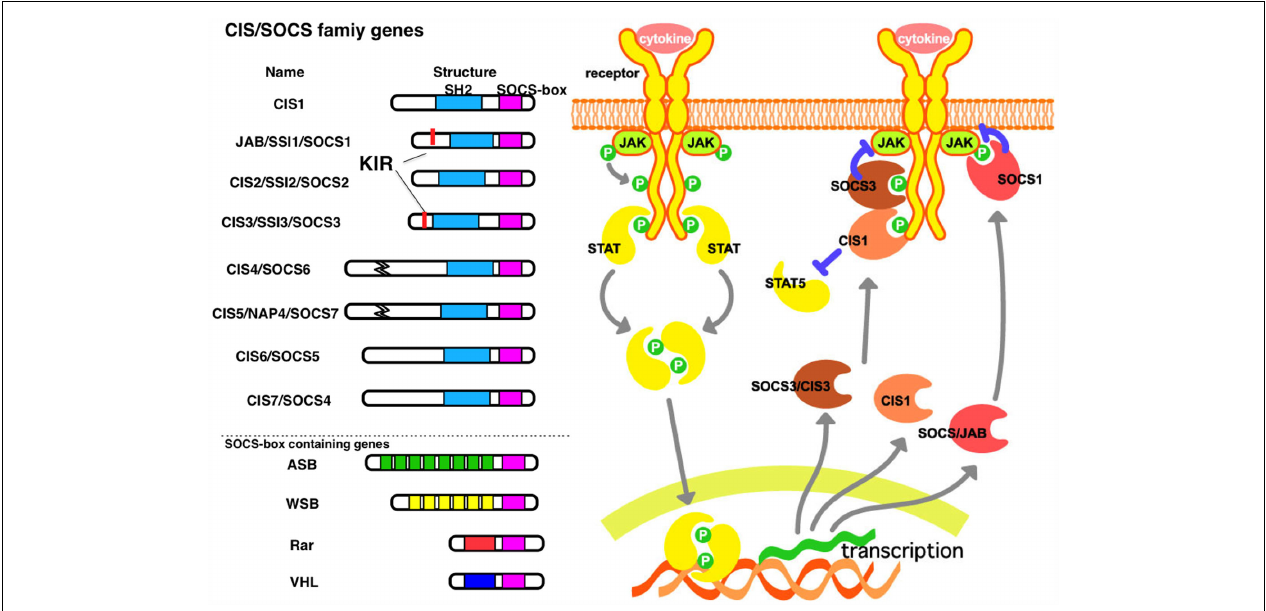
CIS, SOCS1, and SOCS3. All of these are induced by cytokine stimulation. CIS binds to the STAT5 activating receptors, thereby suppressing further activation of STAT5 and inducing degradation of the receptor. SOCS1 binds to JAKs, and SOCS3 binds to the receptor through the SH2 domain, but both inhibit JAK activity through KIR.These complexes may be degraded by ubiquitination and proteasomal degradation recruited through the SOCS